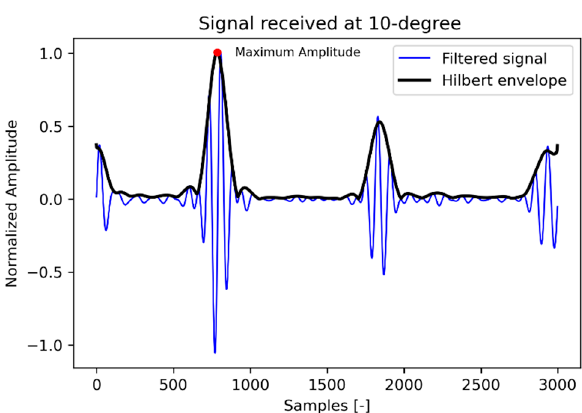
Figure 13. Signal received in polyamide hemispherical test specimen.